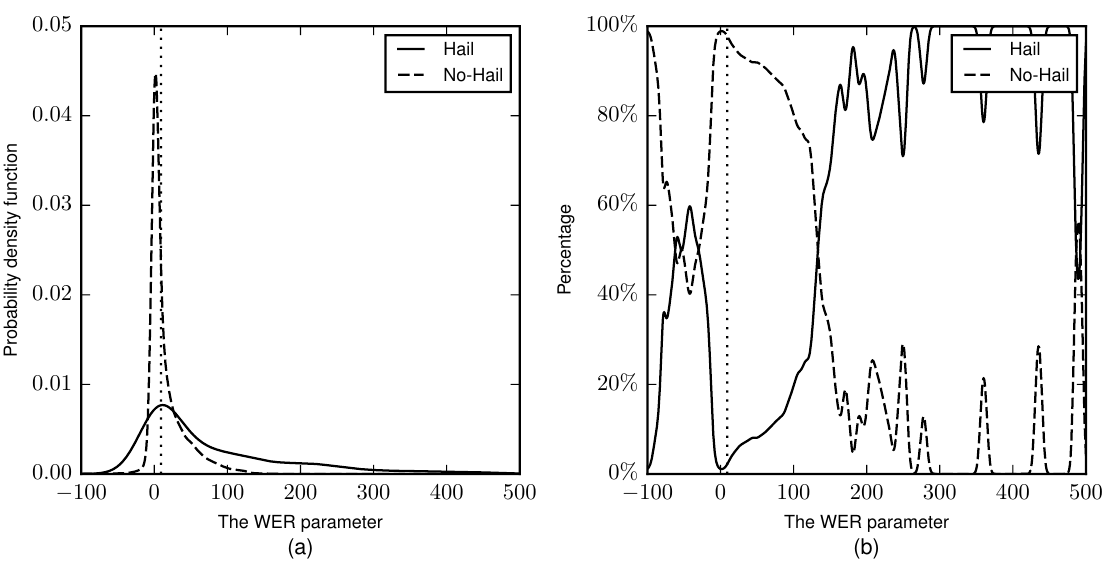
Figure 12. Comparison of WER parameters. ( a ) Probability density function of the WER parameter. ( b ) Proportion of hail and no-hail samples when the WER parameter changes. The dotted line indicates the interclass mean of linear discriminant